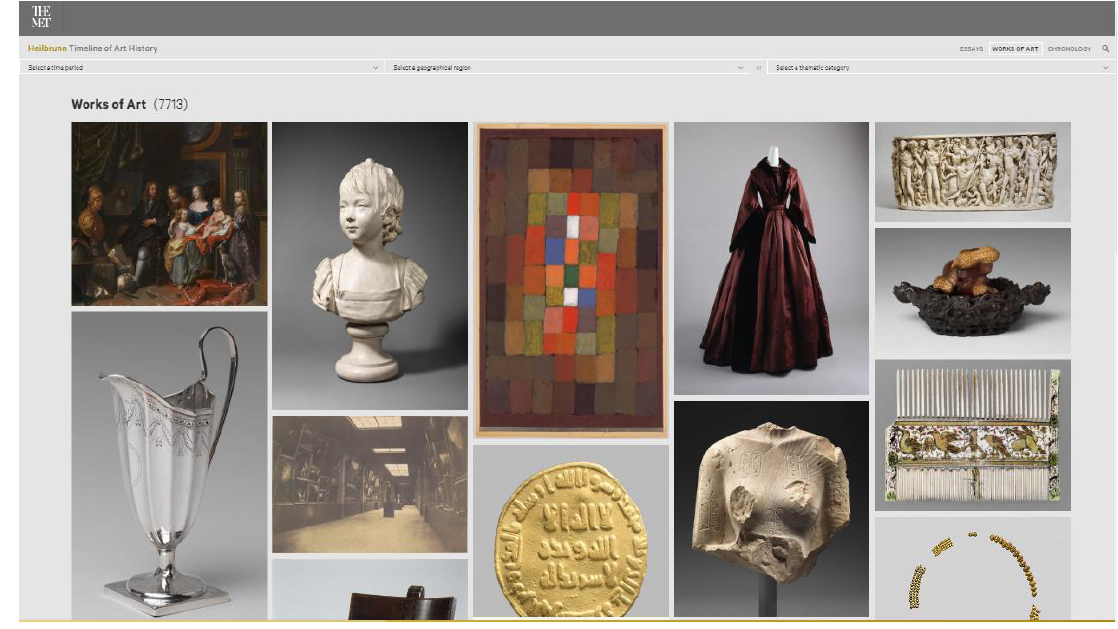
Figure 1. Timeline of Art History, Metropolitan Museum of New York,